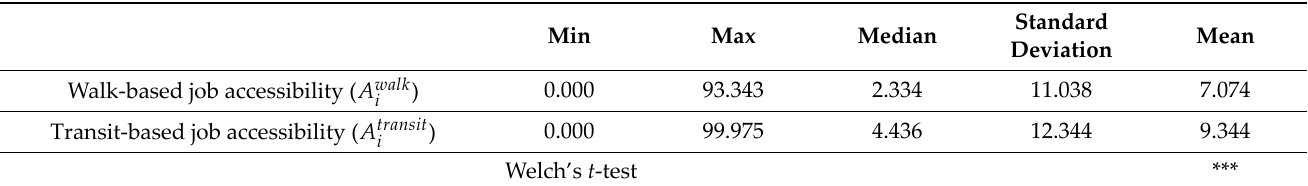
Table 1. Descriptive statistics of walk‑based and transit‑based job accessibility measured at the par‑ cel